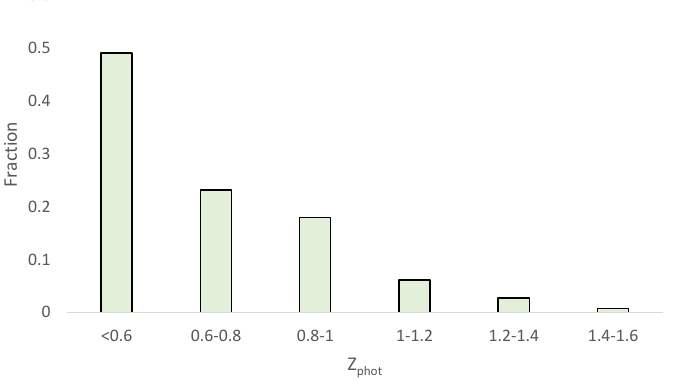
Figure 4. The redshift distribution of the HST galaxies based on the photometric